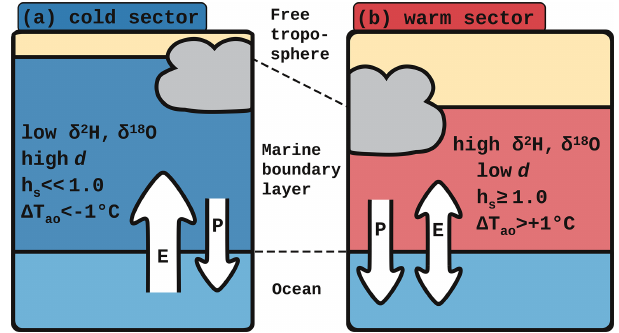
Figure 1. Schematic of air–sea interactions in (a) the cold and (b) the warm sector of an extratropical cyclone. E denotes ocean evaporation and, if directed downward, dew formation, and P de- notes precipitation. h s is the relative humidity with respect to sea surface temperature and (cid:49)T ao the difference between the air and sea surface temperature. For details see